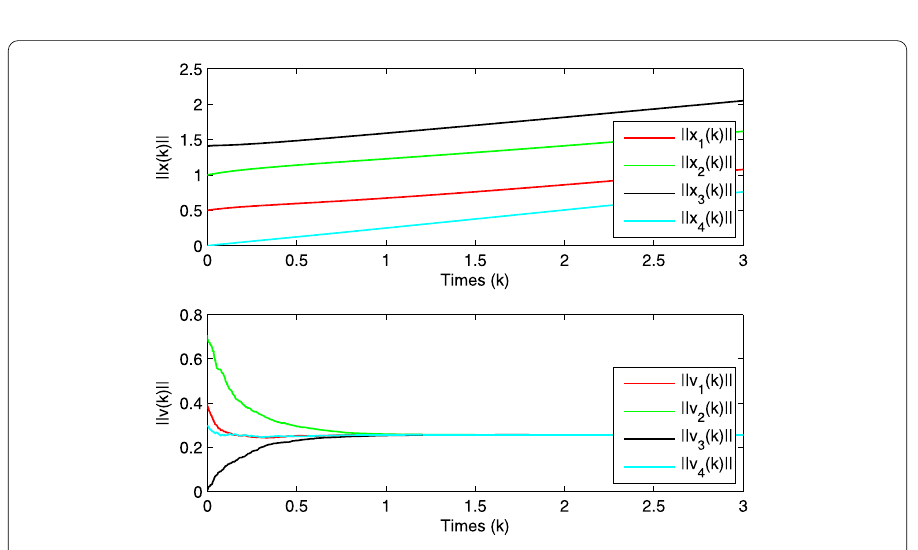
Figure 4 The norms of position and velocity trajectories with α = 1.2 in Case